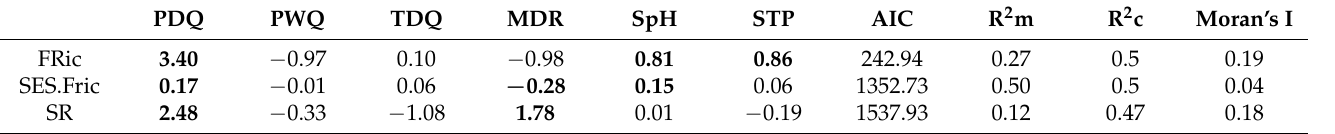
Table 3. Summary of the mixed linear models analyzing the effects of environmental variables on the functional richness (FRic), standardized effect of the functional richness (SES.FRic), and (log- transformed) species richness [log(SR)]. Estimate values are the standardized regression coefficients of predictors. The marginal (R 2 m) and conditional (R 2 c) coefficients of determination are presented. Values in bold indicate p values <